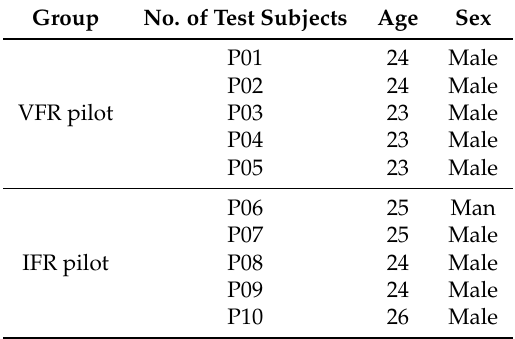
Table 1. Specification of the groups of persons taking part in the experiment.